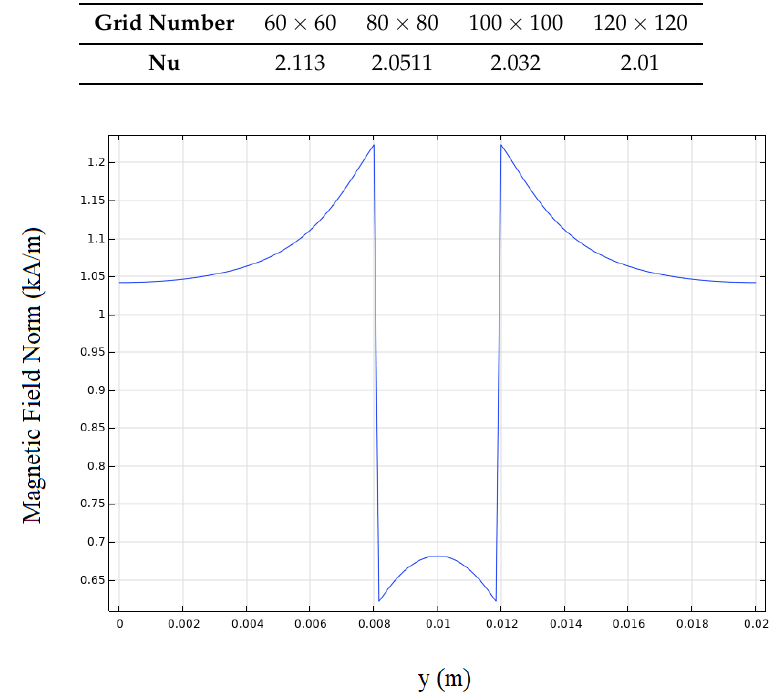
Figure 3. Magnetic field Norm normal to magnet direction.